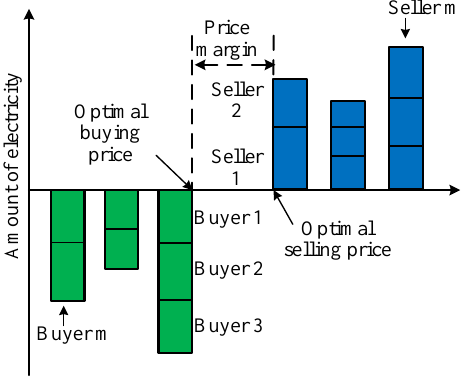
Figure 2. Matching process of continuous double auction.